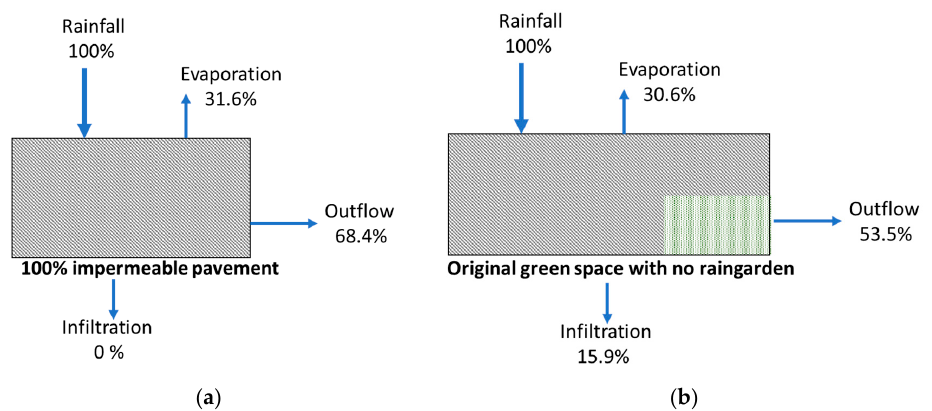
Figure 9. Annual hydrologic cycles of the two field sites without LID facilities. ( a ) Site without permeable pavement; ( b ) site without a raingarden and storage tank.